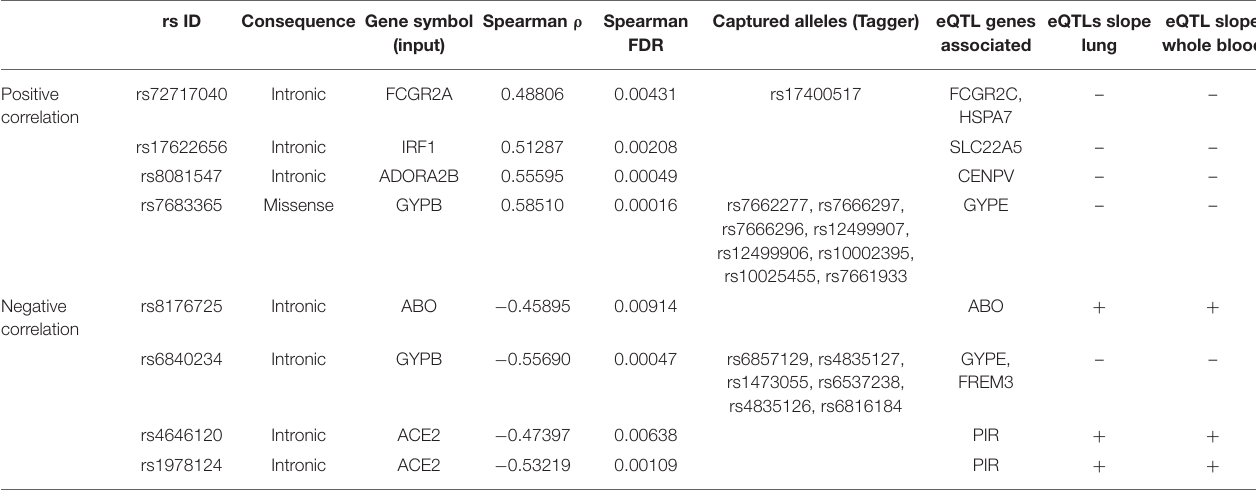
TABLE 5 | List of variants finally